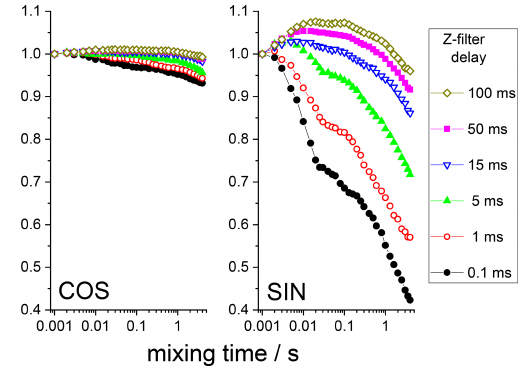
Figure 7. COS and SIN components of the 15 N CSA CODEX mix- ing time dependence in BOC glycine at different Z -filter delays. All the dependences were normalized to the same initial amplitude. MAS 20kHz, 108kHz CW 1 H decoupling during the de(re)phasing periods, NT R 2ms, CP contact time